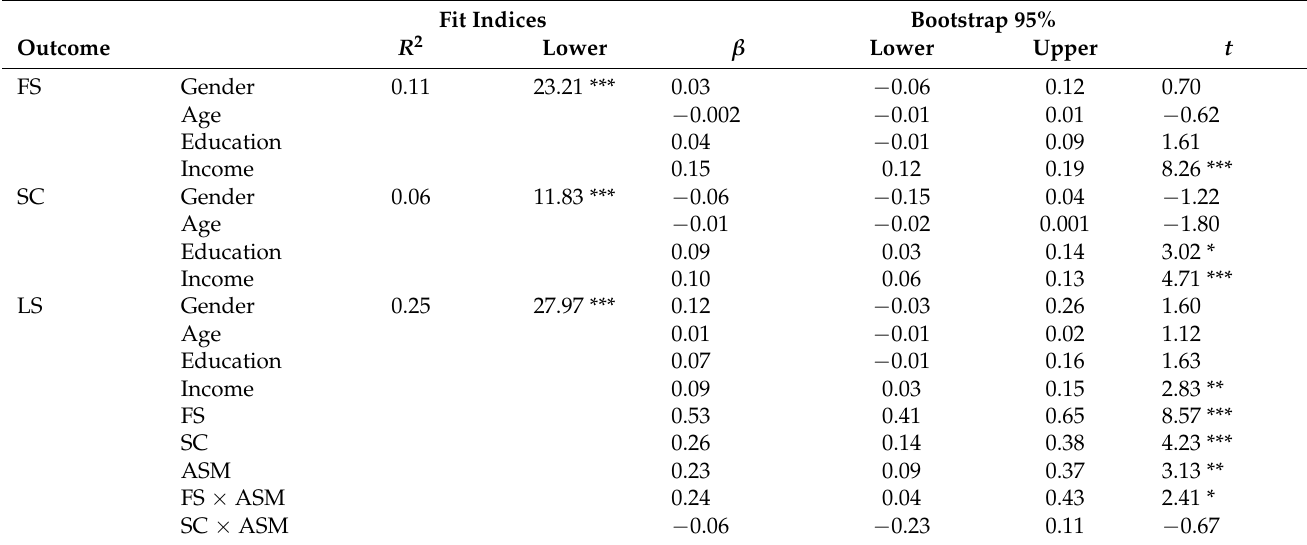
Table 6. Testing the moderated mediation effects for Life Satisfaction in study